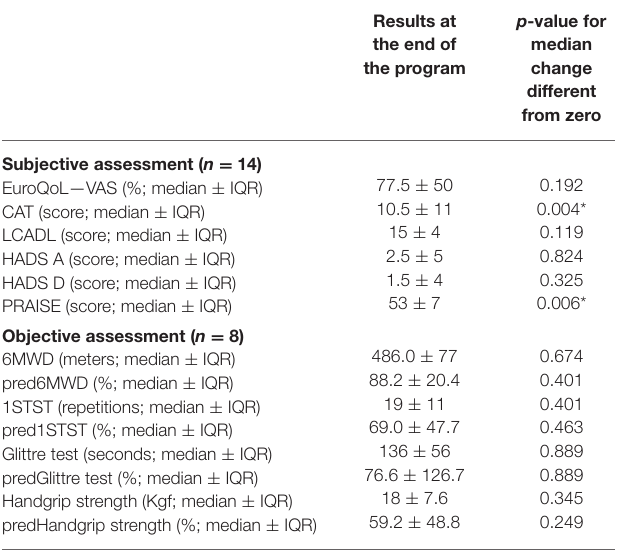
TABLE 3 | Pulmonary telerehabilitation outcomes.